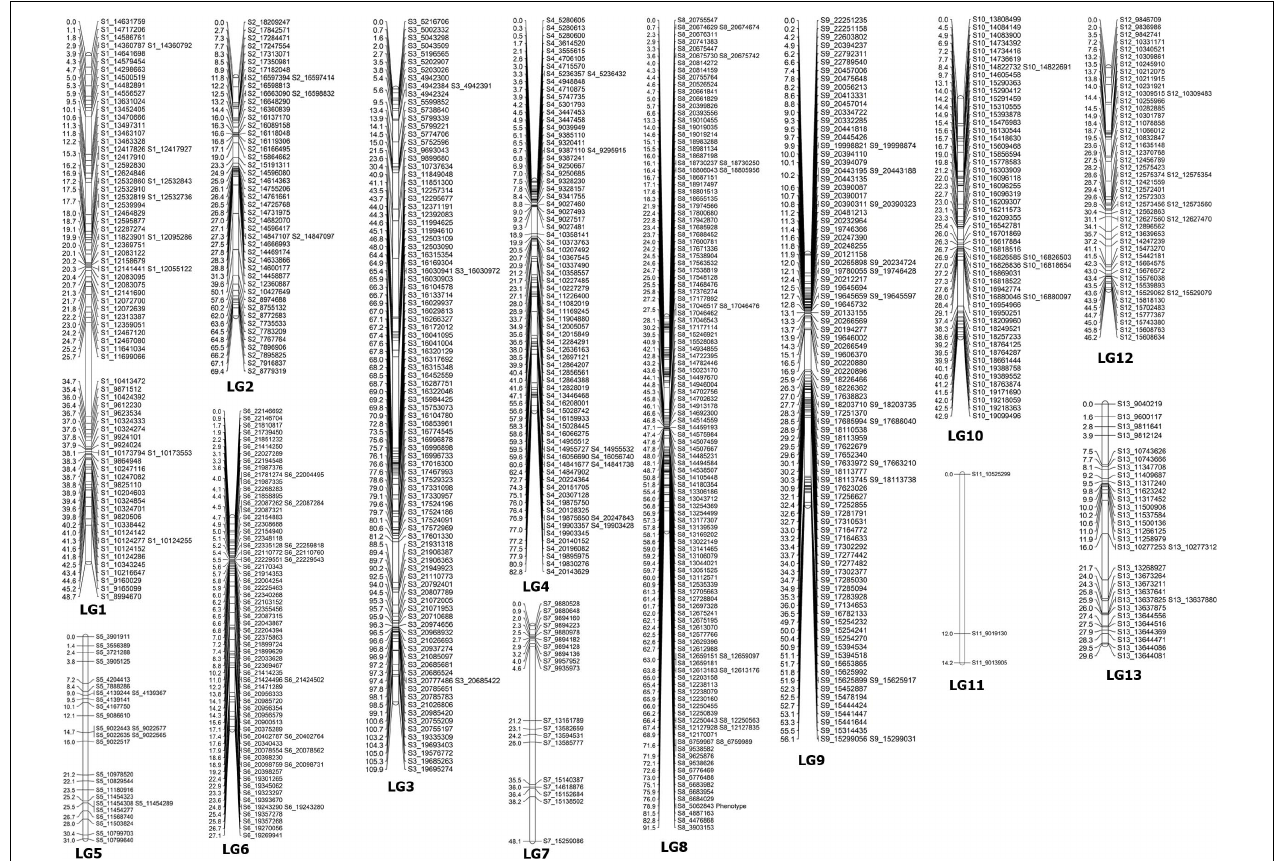
FIGURE 2 | A genetic linkage map of sesame constructed using the F 2 population of PI 599446 × Muganli-57.